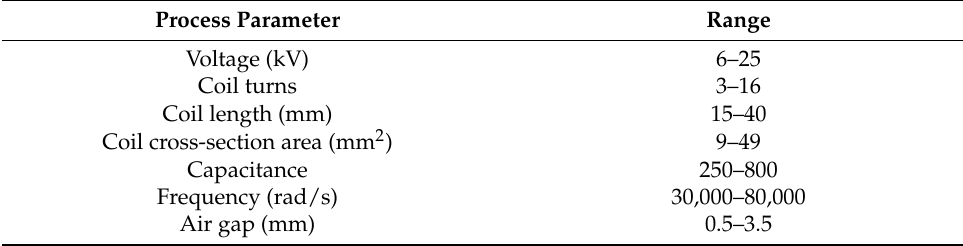
Table 3. Details of the FEM.